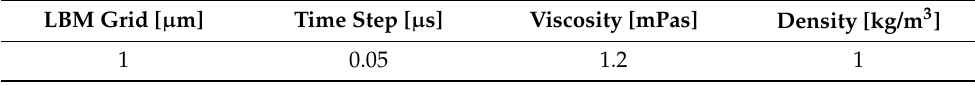
Table A1. Simulation parameters,